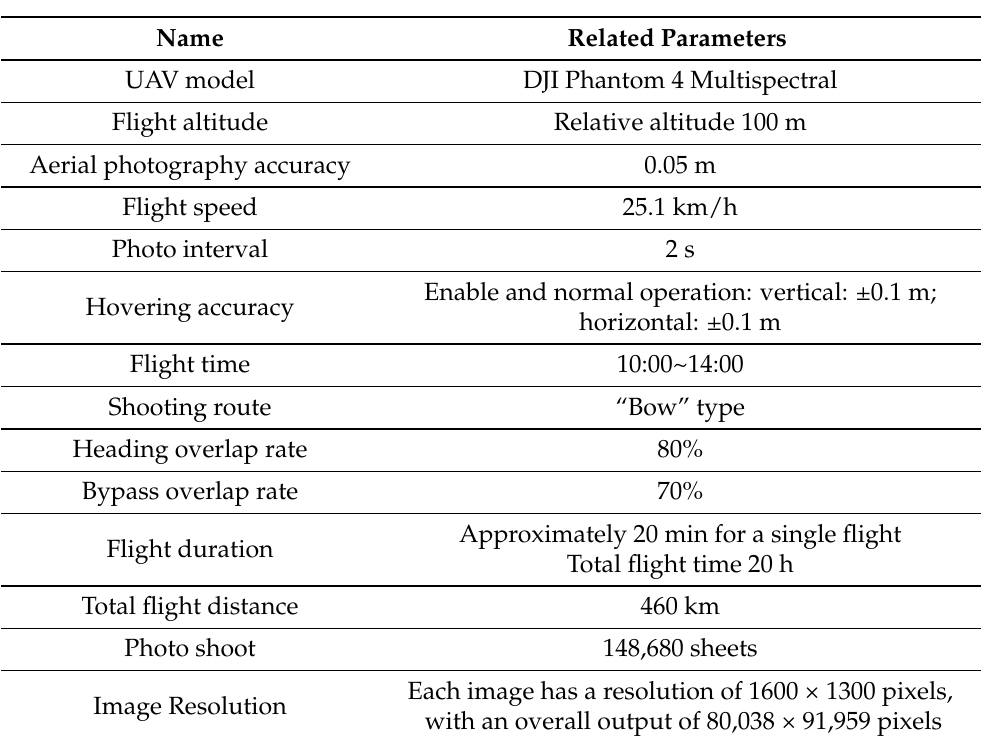
Table 1. UAV-related parameters and